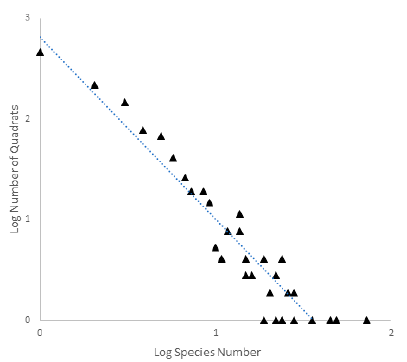
Figure 5. Relationship between the log of the numbers of quadrats and log of the numbers of species for the PASCALIS project. The relationship between the two is Y (number of quadrats) = 677 x X(Number of Species) − 1.76 . Data from Deharveng et al. [49].